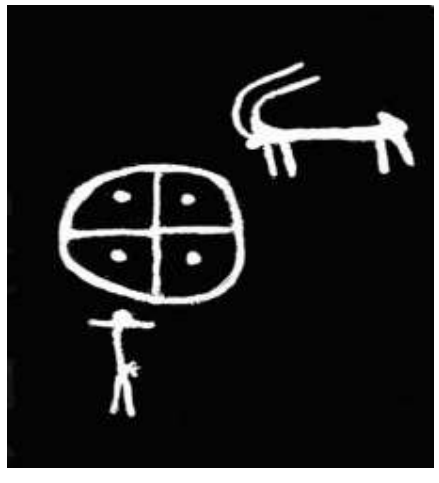
Figure 4. Hawraman, Bendoul village, Sivieh-Havar.